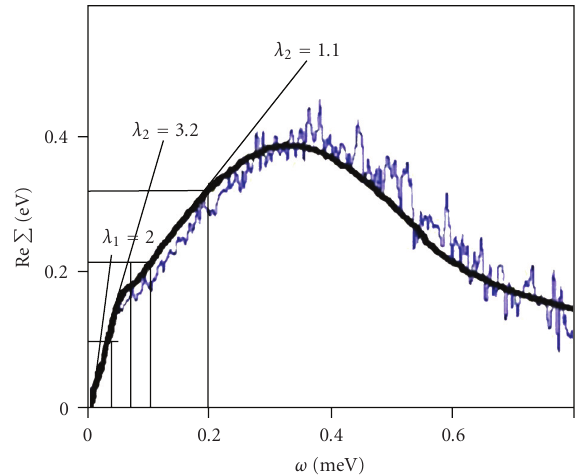
Figure 16: Figure 4b from [136]: Re Σ ( ω ) measured in Bi 2212 (thin line) and model Re Σ ( ω ) (bold line) obtained in [136]. The three thin lines ( λ 1 , λ 2 , λ 3 ) are the slopes of Re Σ ( ω ) in di ff erent energy regions—see the